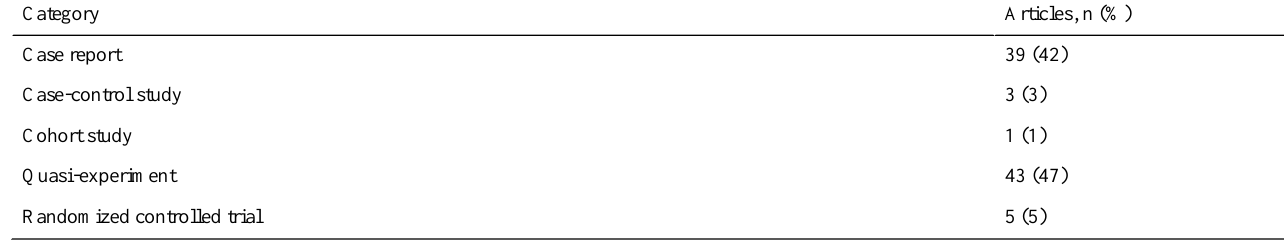
Table 3. Study types (N=91).